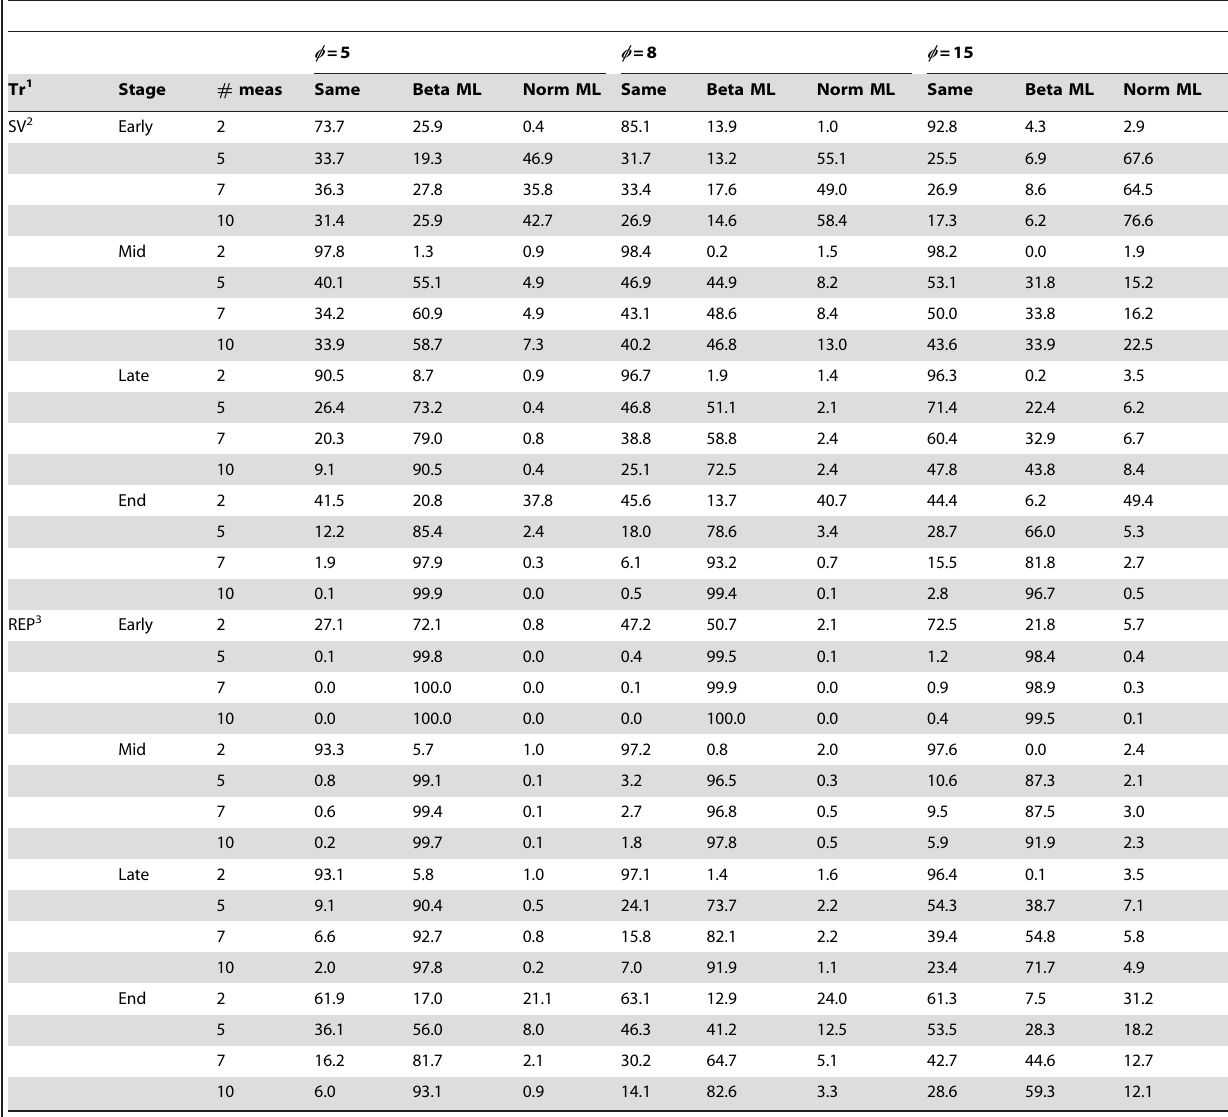
Table 5. Percent of beta error simulations with normal error ( s =0.05) added, for which AIC c selected maximum likelihood (ML) estimation with beta or normal errors best or found no difference between the models (Same) from each simulation ( k = 0.0002).